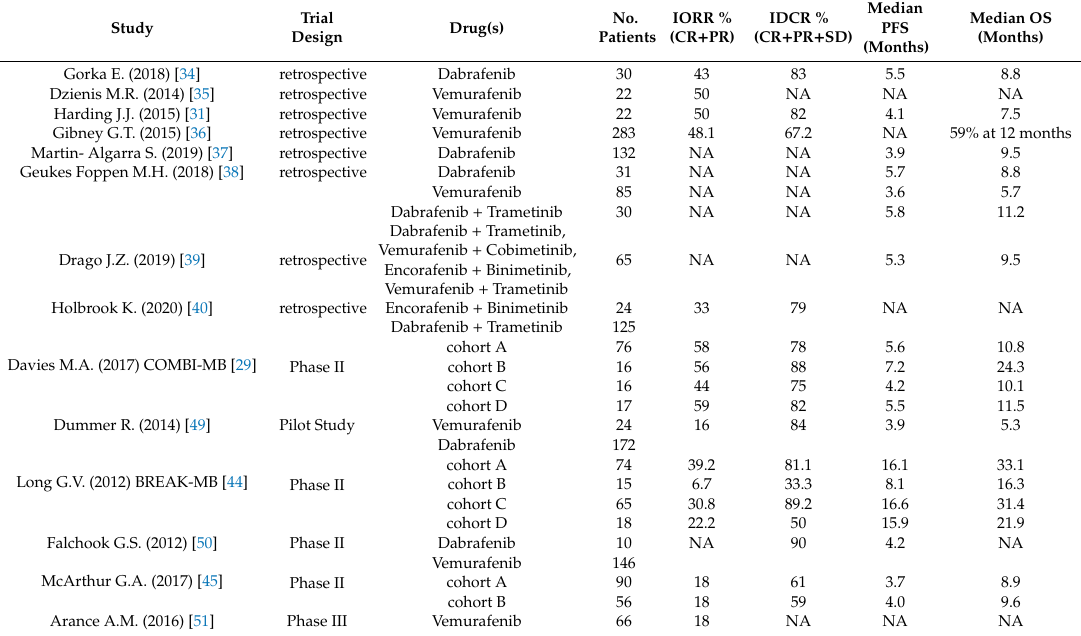
Table 1. Study of BRAF and MEK inhibitors in melanoma with brain